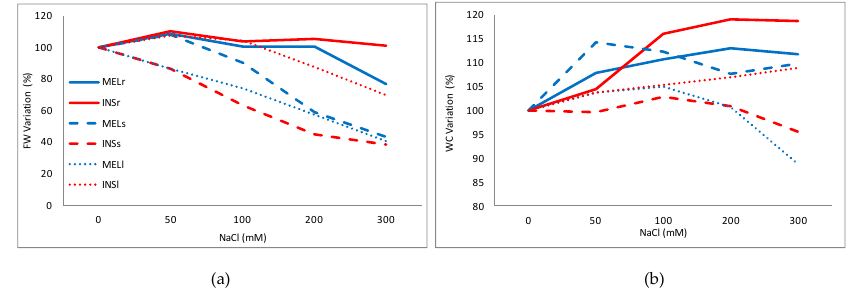
Figure 2. Reduction of fresh weight (FW) ( a ) and water content (WC) ( b ) in roots (MELr and INSr), stems (MELs and INSs), and leaves (MELl and INSl) of Solanum melongena (MEL; blue lines) and S. insanum (INS; red lines) plants after 25 days of salt treatments at the indicated NaCl concentrations. Values are shown as percentages of the corresponding controls (0 mM